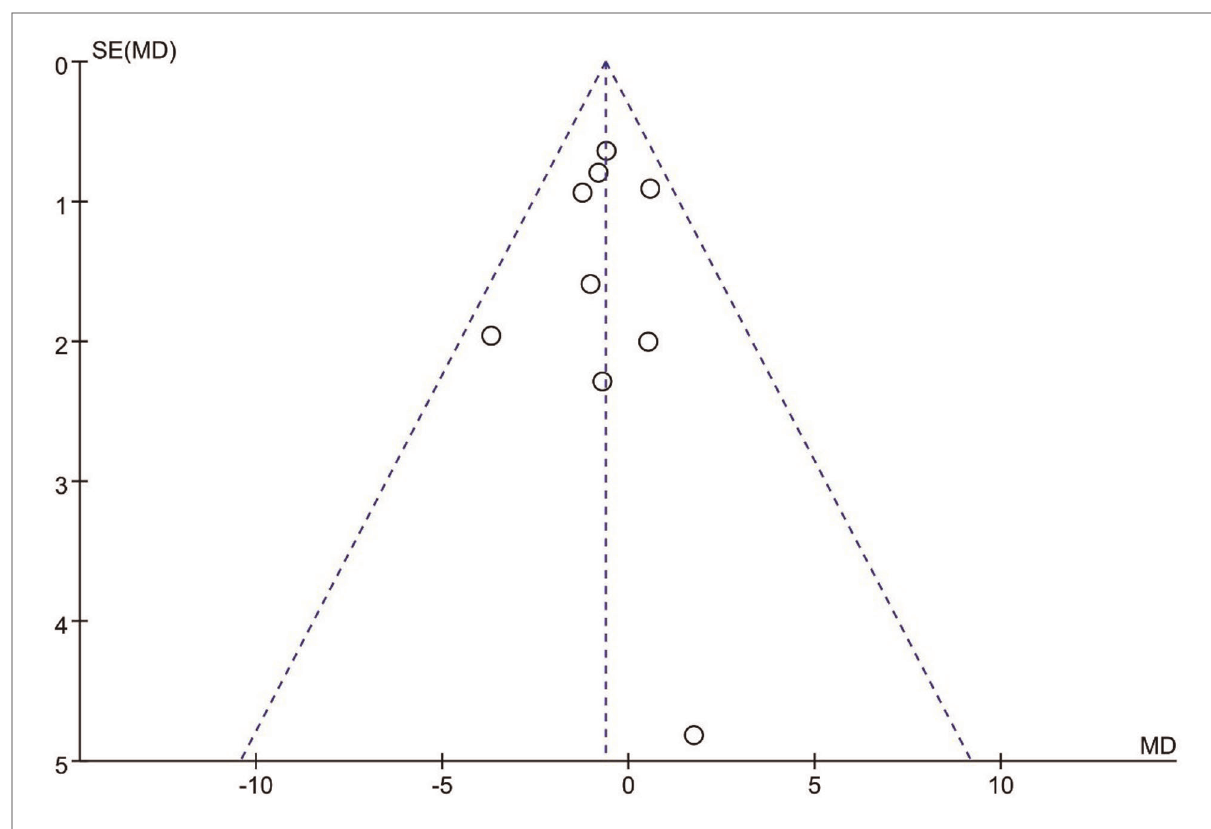
FIGURE 10 Publication bias of ODI UBE vs MED.